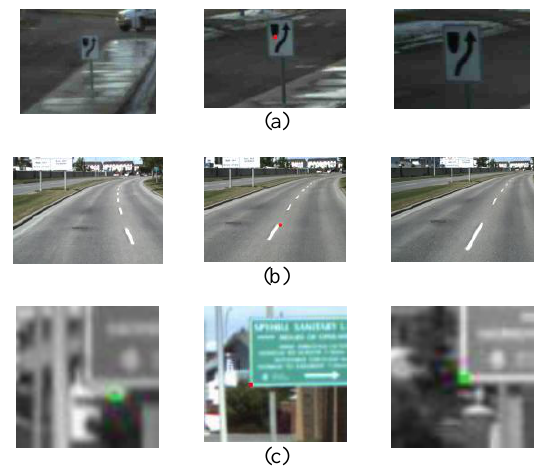
Figure 1. Difficulties of MMS image matching: (a) Image scale variations, (b) Image viewing angle variations, (c) Object